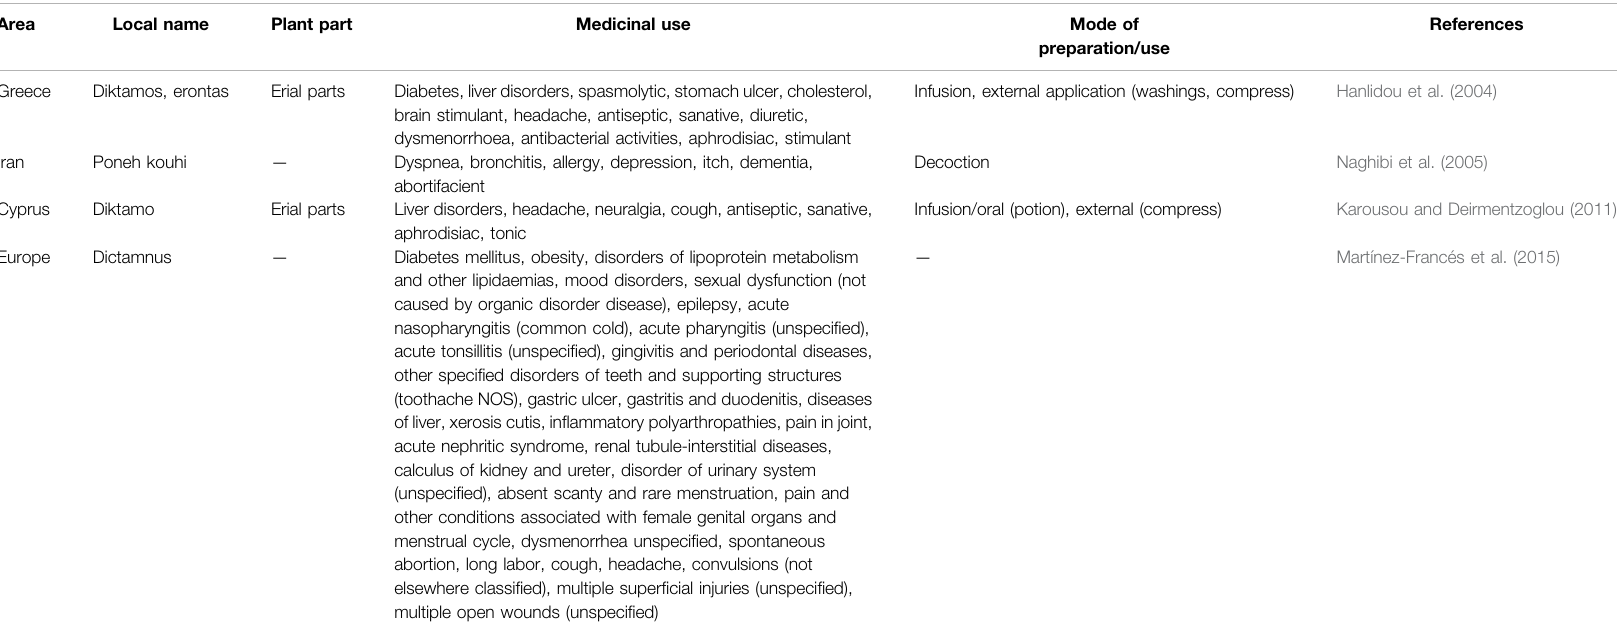
TABLE 3 | Medicinal uses of Origanum dictamnus derived from ethnobotanical and ethnopharmacological studies.